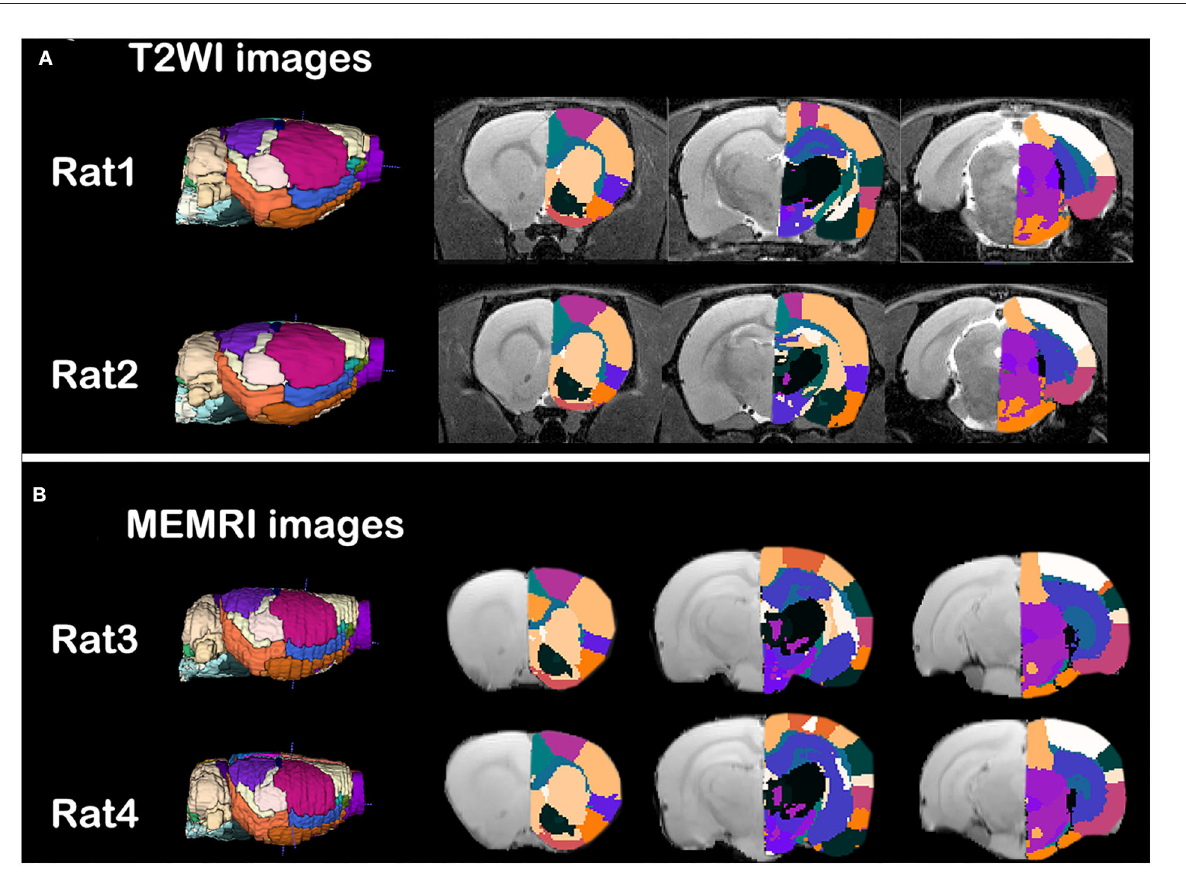
FIGURE2 Qualitative evaluation of the individual parcellations of (A) T2WI images and (B) intercranial mean MEMRI images of rat brain. Four rats were randomly selected. Right side of the individual parcellations was shown in color scaled and superimposed on the corresponding MRI image. The T2WI/MEMRI MRI images were shown in gray scaled as